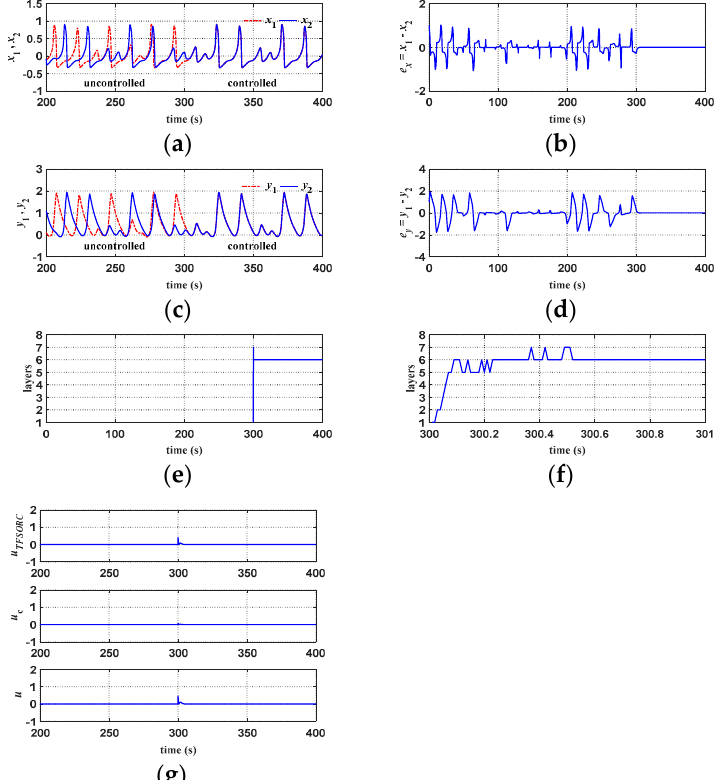
Figure 14. Simulation results of ATFSORC chaotic system synchronization control ( g = 0.01, Cut-in control at 300 sec): ( a ) x 1 , x 2 response for ATFSORC; ( b ) error e x for ATFSORC; ( c ) y 1 , y 2 response diagram for ATFSORC; ( d ) Error e y for ATFSORC; ( e ) Number of association memory layers for ATFSORC; ( f ) Number of association memory layers for ATFSORC (partial); ( g ) Control amount for ATFSORC.